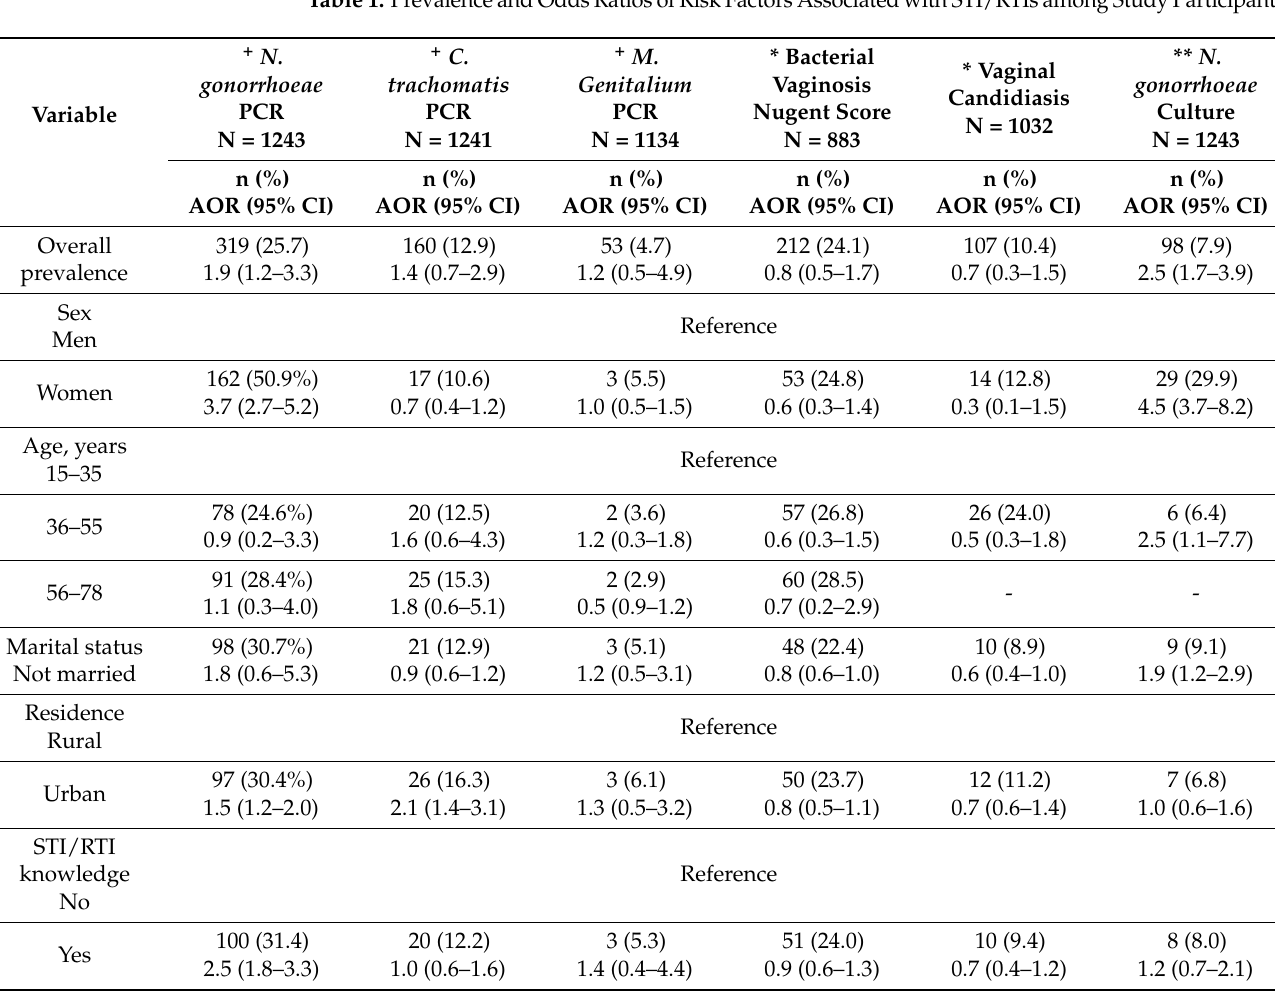
Table 1. Prevalence and Odds Ratios of Risk Factors Associated with STI/RTIs among Study